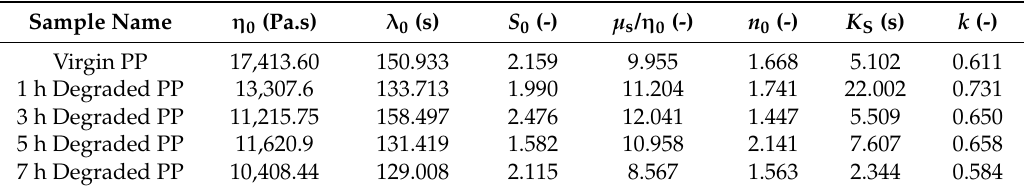
Table 4. Yao model parameters for T = 180 ◦ C.